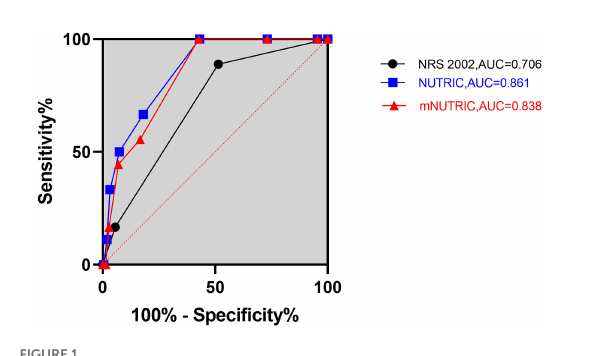
FIGURE 1 Prognostic accuracy of the NRS 2002, NUTRIC, and mNUTRIC to predict 28-day mortality analyzed by receiver operating characteristic curves. The black line with cycle represents the